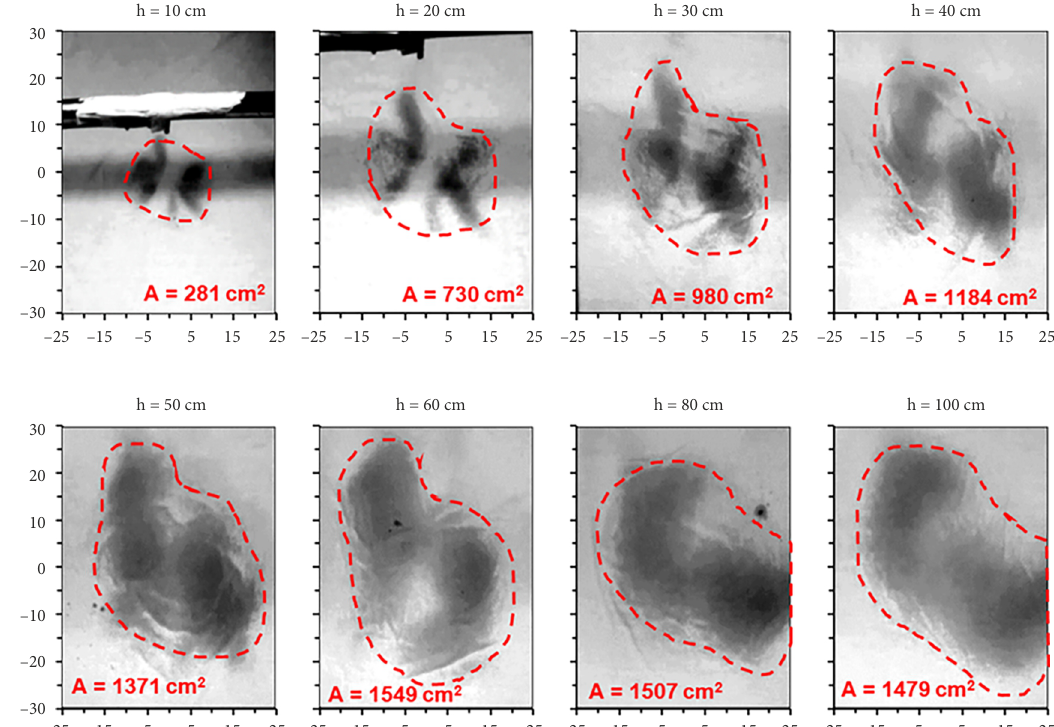
Figure 6. Wetting patterns at distance (h) from the